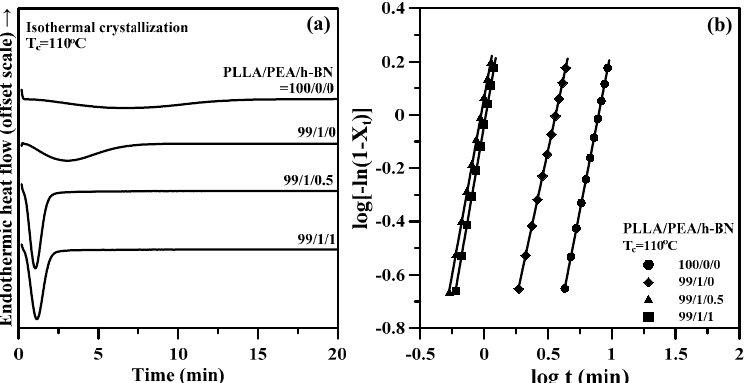
Figure 1. ( a ) Di ff erential scanning calorimetry (DSC) traces at an isothermal crystallization temperature Figure 1. ( a ) Differential scanning calorimetry (DSC) traces at an isothermal crystallization of 110 ◦ C; ( b ) The Avrami plots of neat poly( l -lactic acid) (PLLA), PLLA / poly(ethylene adipate) (PEA) temperature of 110 °C; ( b ) The Avrami plots of neat poly( ʟ -lactic acid) (PLLA), PLLA/poly(ethylene blend, and PLLA / PEA / hexagonal boron nitride (h-BN) adipate) (PEA) blend, and PLLA/PEA/hexagonal boron nitride (h-BN) composites.